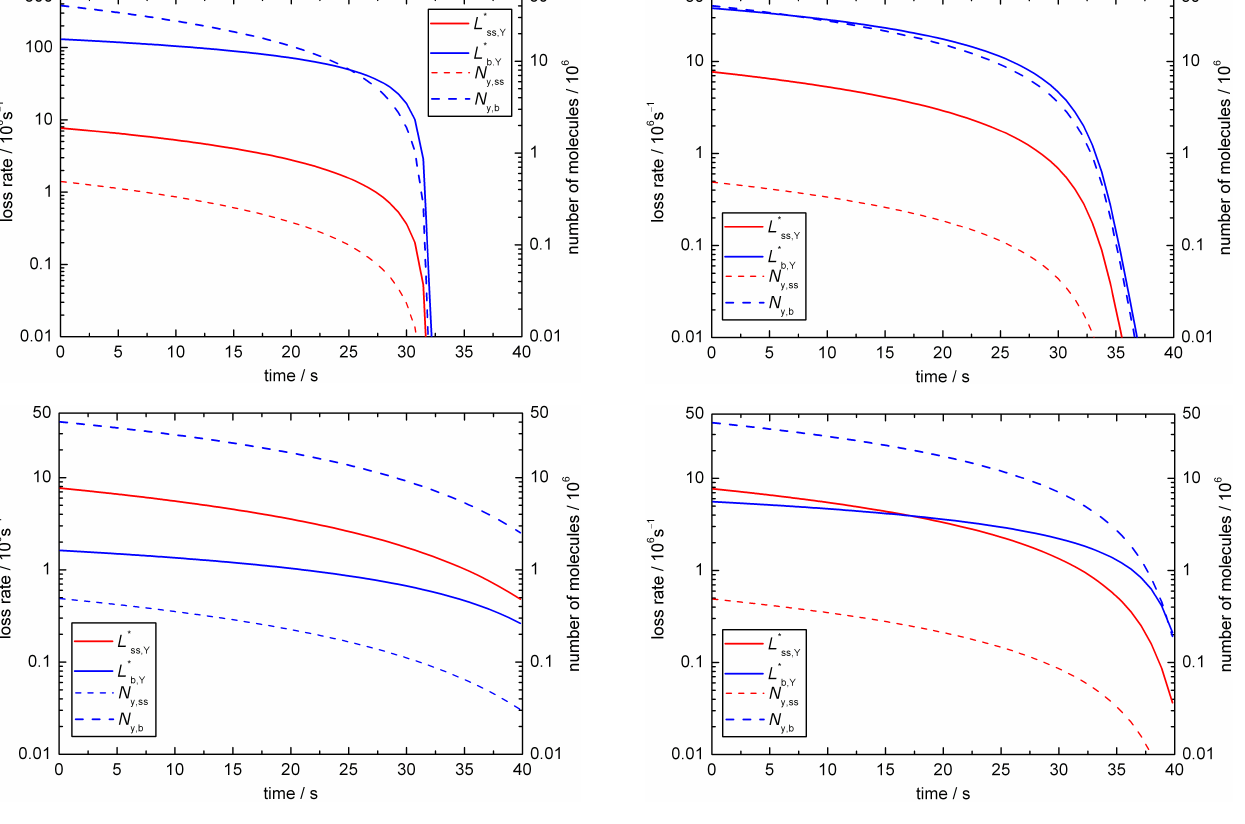
Fig. 4. Temporal evolution of aerosol particle composition and ki- netic parameters in sensitivity studies for BC1 with D b , X (a) ten fold above the literature value and (b) ten fold below. Plots are analogous to Fig.